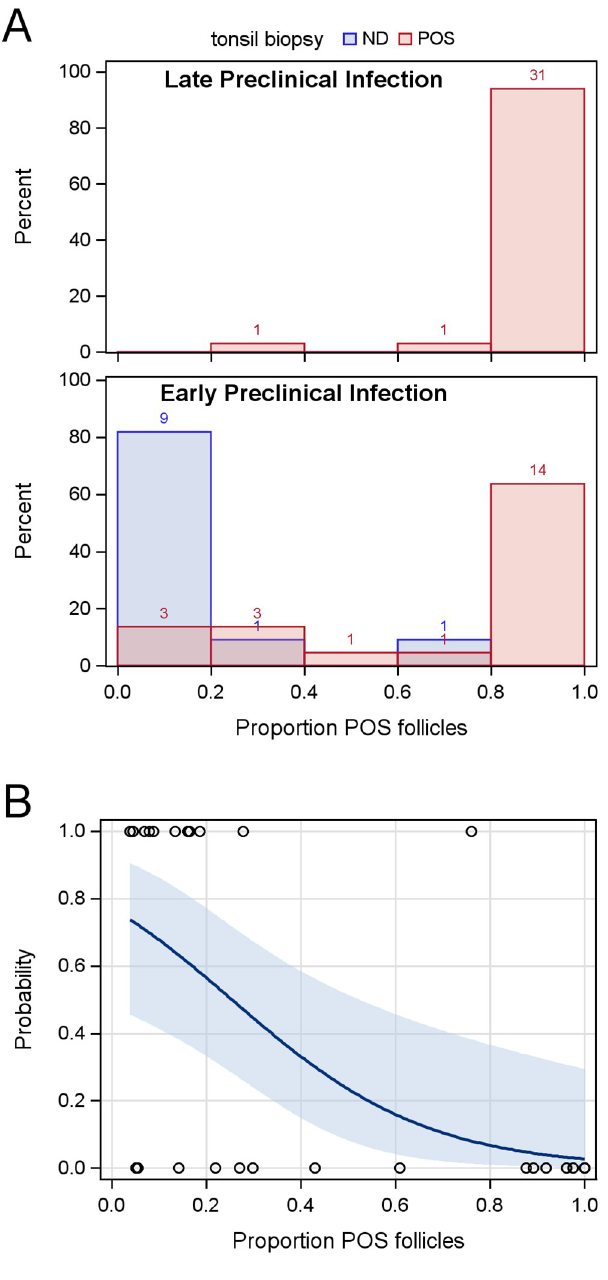
Fig 2. The relationship of tonsil biopsy results in white-tailed deer with estimates of the proportion of tonsil follicles positive for PrP CWD accumulation. (A) The frequency (bar counts) of true positive (POS) and false negative (ND) tonsil biopsy results as stratified by stage of preclinical infection. (B) The predicted probabilities of a false negative tonsil biopsy result in white-tailed deer with early preclinical infection as a function of the estimated proportion of tonsil follicles positive for PrP CWD . The confidence band signifies the 95% confidence limits. this two-bite biopsy sampling technique in 79 preclinical, naturally infected farmed WTD from nine CWD-positive herds from across the United States. The study group included simi- lar proportions of deer with early and late preclinical infections, and each infection stage was